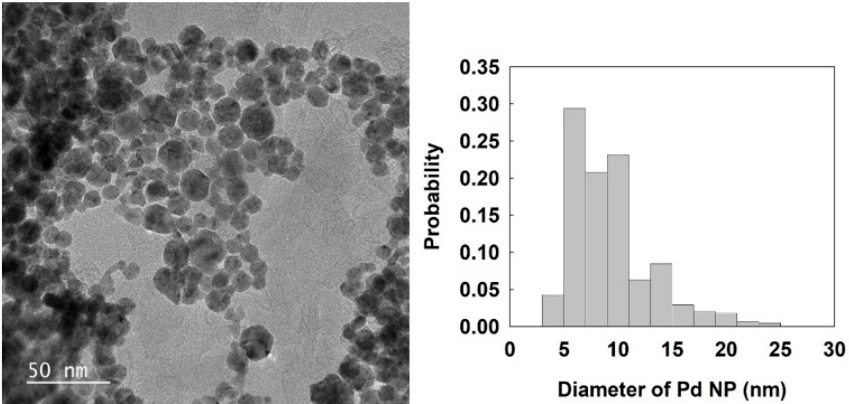
Figure 1. TEM image and size distribution of Pd NPs. The scan bar is 50 nm. The average size and standard deviation of Pd NPs were 9.3 (±3.8) nm.